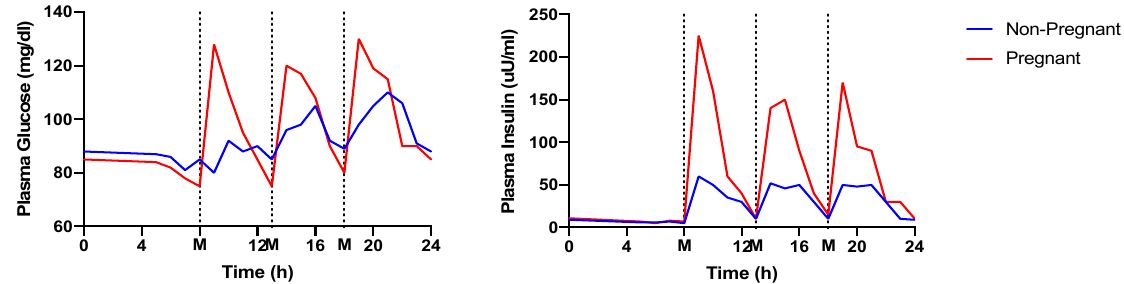
Figure 1. Diurnal circulating concentrations of glucose (left panel) and insulin (right panel) in healthy non-pregnant and healthy pregnant females during the third trimester of gestation. Adapted from reference [30].